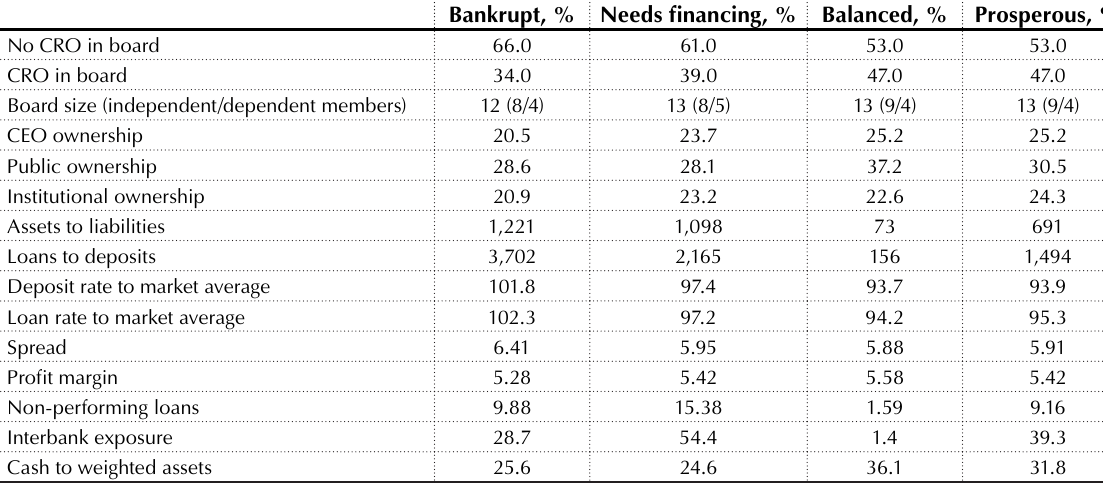
Table 1. Summaries of monitored variables for each final state